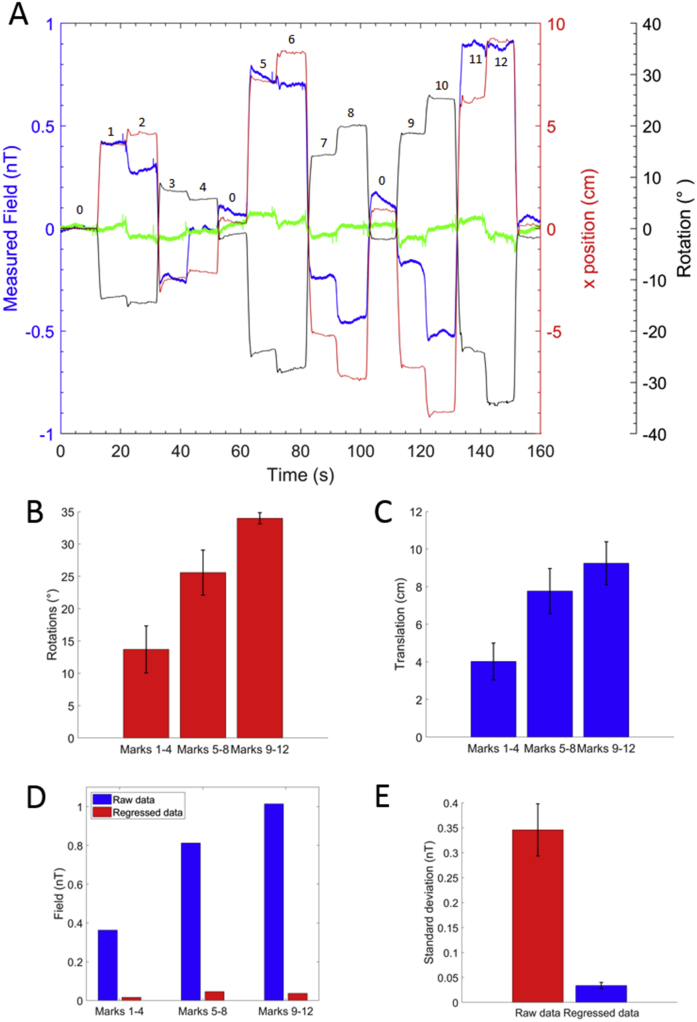
A) The output of a single OPM within an array of 18 worn by the subject is displayed in blue. The magnetic field data are then compared with the x translation (red) and yaw rotation (black) of the rigid body. The text labels identify the order in which the positions were viewed during the experiment. Even for the largest motions, which were at the limit of what was deemed comfortable for the subject, the sensors stayed within their ±1.5 nT dynamic range. The measured field following regression with motion parameters and the four reference magnetometers is shown in green. B) The magnitude (pitch2+roll2+yaw2) of the rotation required to move from mark 0 to each mark is averaged over the 3 subsets. C) The magnitude (x2+y2+z2) of the translation required to move from mark 0 to each mark is averaged over 3 subsets each containing 4 marks. D) Reduction in field following regression at each subset of marks shown for the sensor which detected the largest (positive) field over the whole experiment. E) Reduction in the standard deviation over time of raw sensor outputs during the entire 160 s of the experiment following regression. Results are averaged over all 18 sensors in the scanner-cast.